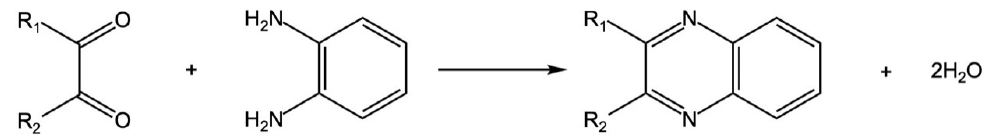
Figure 1. The reaction equation of OPD and α -DCs. Figure 10. The glucose produces BD by reverse aldol condensation and “peeling-off” mechanism.